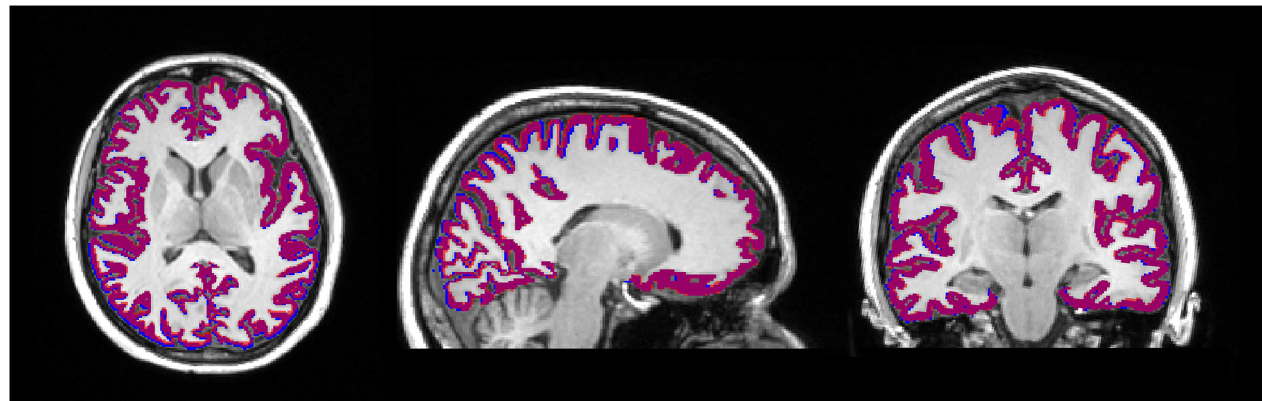
Fig 2. Exemplary overlay of the cortical segmentations from the FreeSurfer parcellations of the distortion corrected (DC) (blue) and not distortion corrected (nDC) (red) images in axial, coronal, and sagittal view. Purple areas indicate the overlap between the two parcellations.